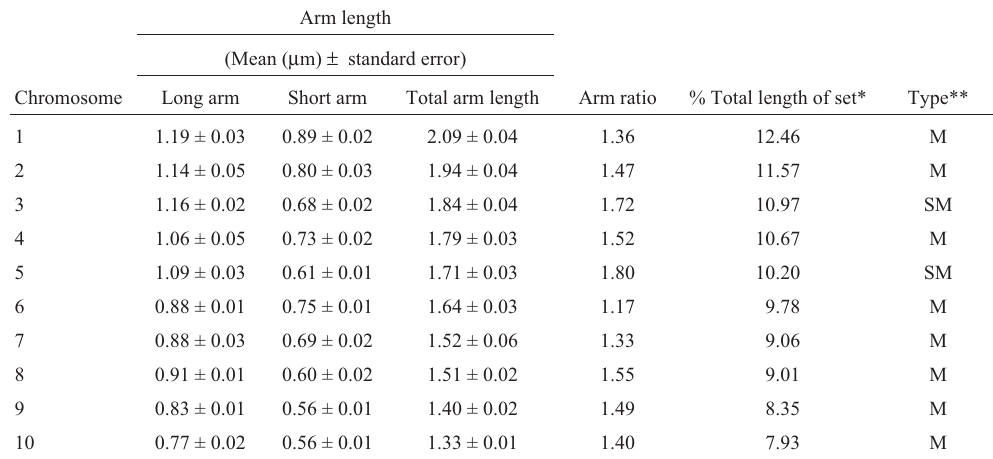
Table 4 - Basic chromosome set of Eupatorium laevigatum .